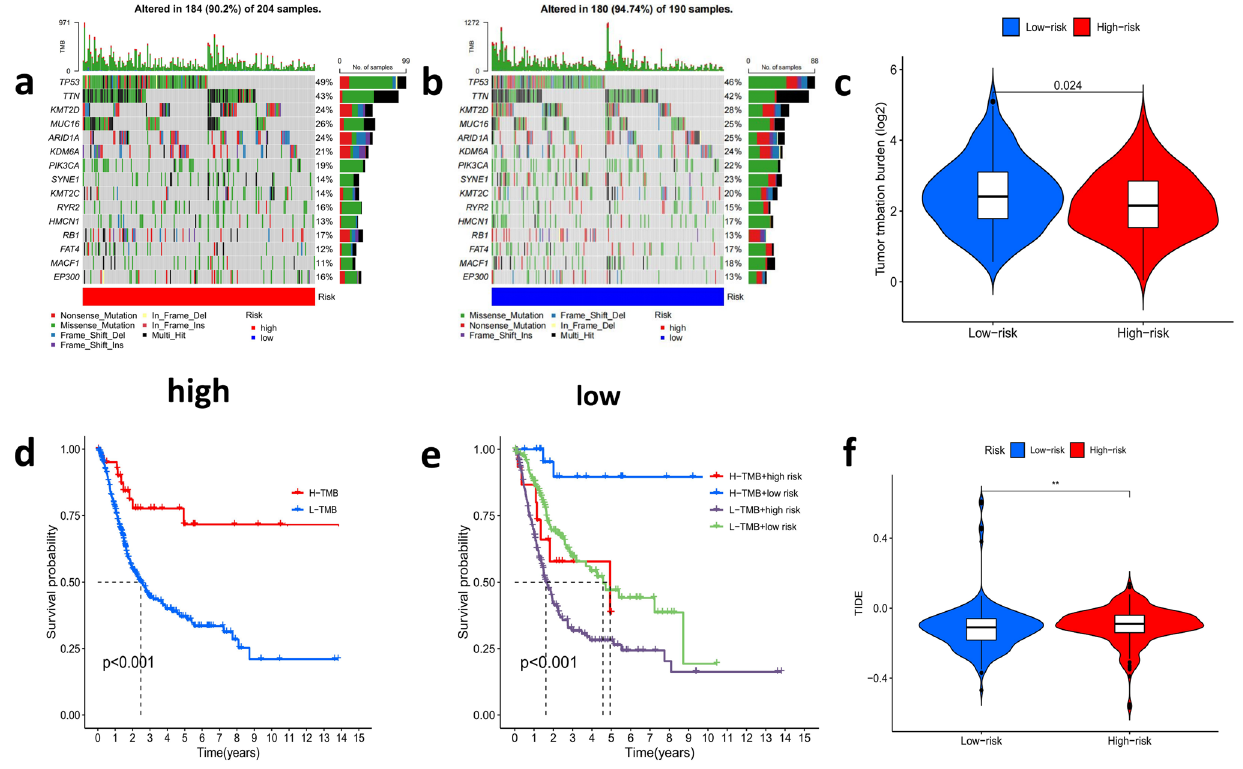
Fig. 10 Tumor mutation burden in different risk groups based on signature and comparison of the tumor immune escape scores a , b Detailed mutation information for each gene in the high- and low-risk group. c The tumor mutation burden outcomes of patients in the high-low mutation group. d The survival outcomes of patients in the high-low mutation group. e The survival outcomes combination of patients in the high-low mutation load group with the high and low-risk group. f Tumor immune escape scores in low-risk group was signifi- cantly lower than that in high-risk group (P <